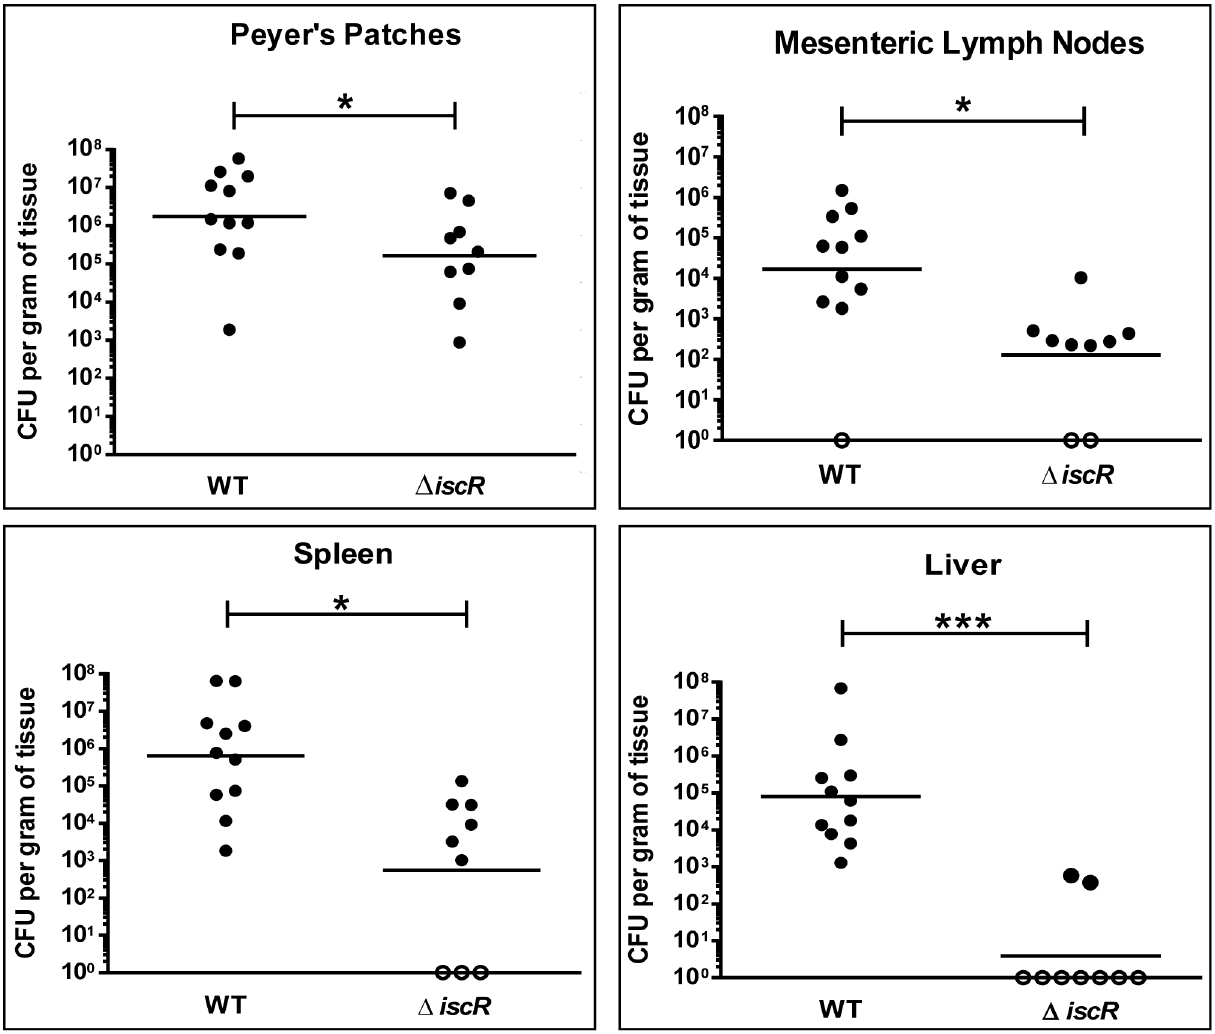
Figure 3. IscR is required for full virulence of Y.pseudotuberculosis . Mice were infected with 2 6 10 8 CFU of either WT Y. pseudotuberculosis or D iscR mutant via orogastric gavage. At 5 days post-inoculation, the Peyer’s patches (PP), mesenteric lymph nodes (MLN), spleens and livers were collected, homogenized and CFU determined. Each symbol represents one animal. Unfilled symbols indicate that CFU were below the limit of detection. The data presented are from three independent experiments. *p , 0.05, ***p , 0.001 as determined by an unpaired Wilcoxon-Mann- Whitney rank sum test. Dashes represent the geometric mean.